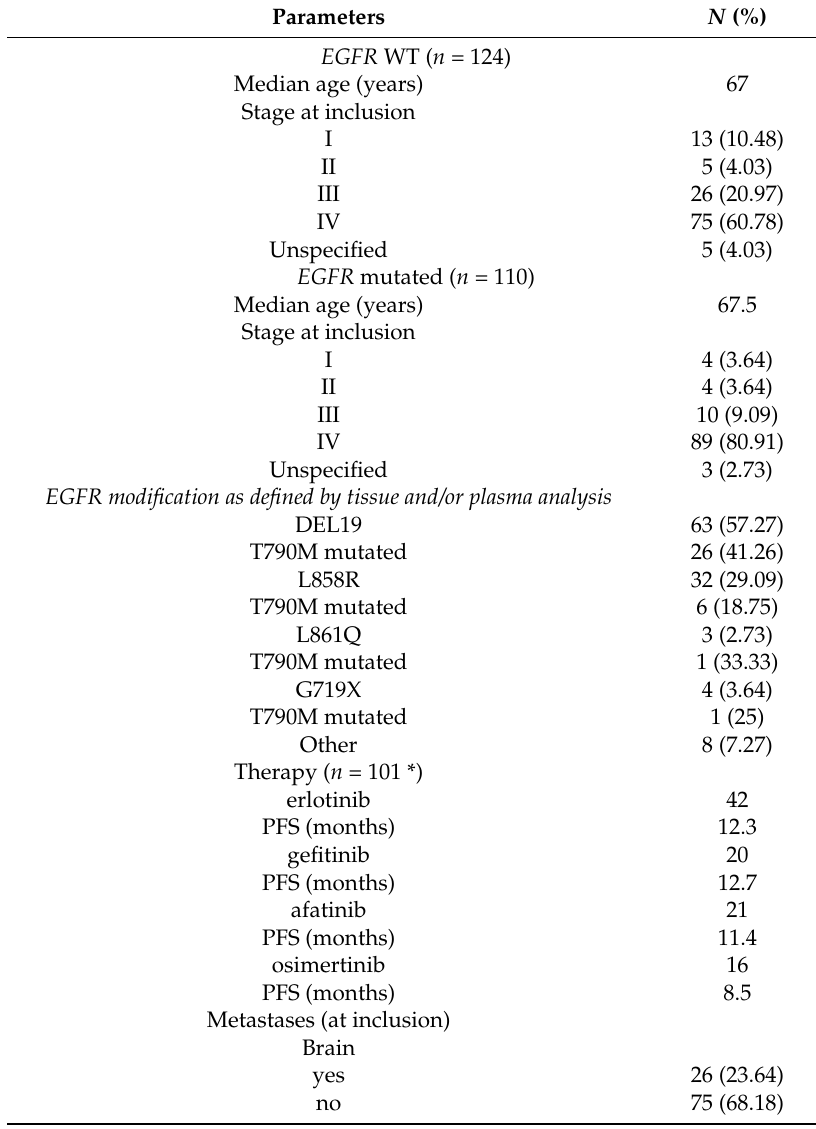
Table 1. Overview of patient